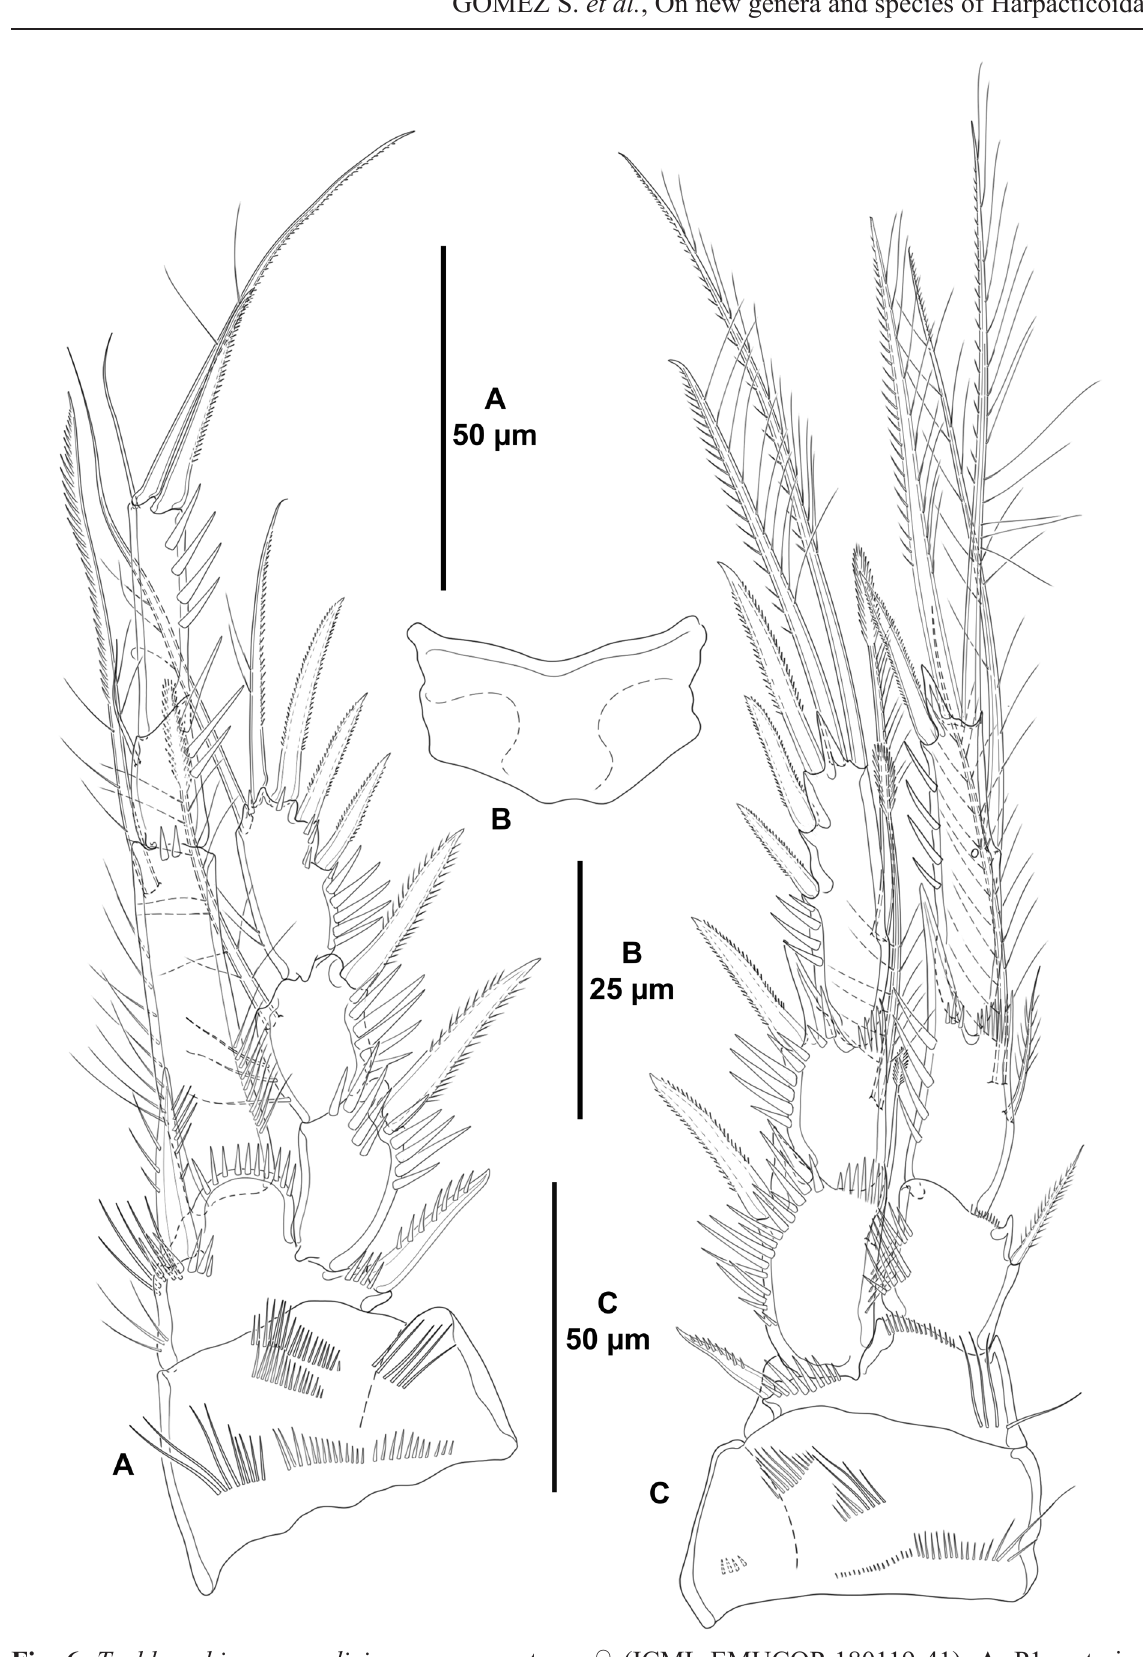
Fig. 6. Typhlamphiascus medici sp. nov., paratype, ♀ (ICML-EMUCOP-180119-41). A . P1, anterior view. B . Intercoxal sclerite of P1, anterior view. C . P2, anterior